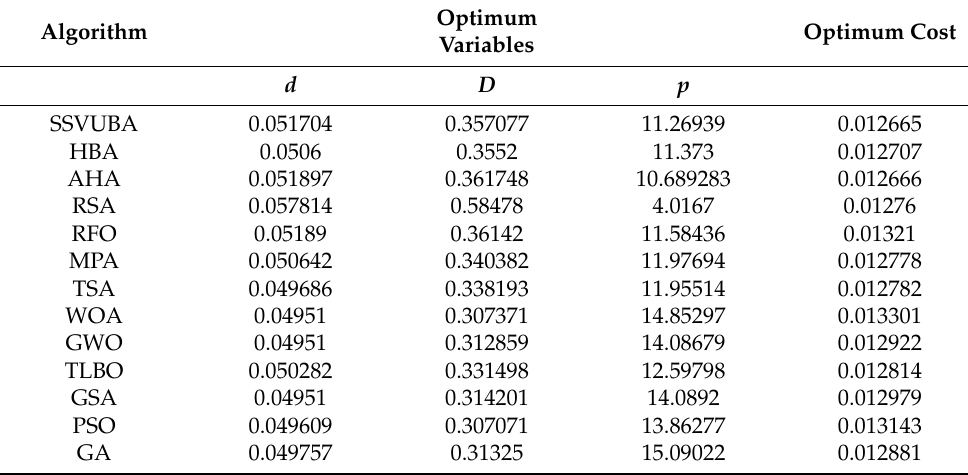
Table 16. Performance of optimization algorithms for the tension/compression spring design problem.